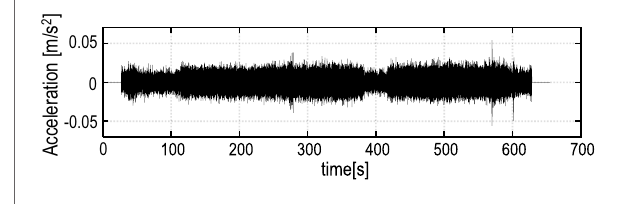
FIGURE 10 | Microtremor ground motion .